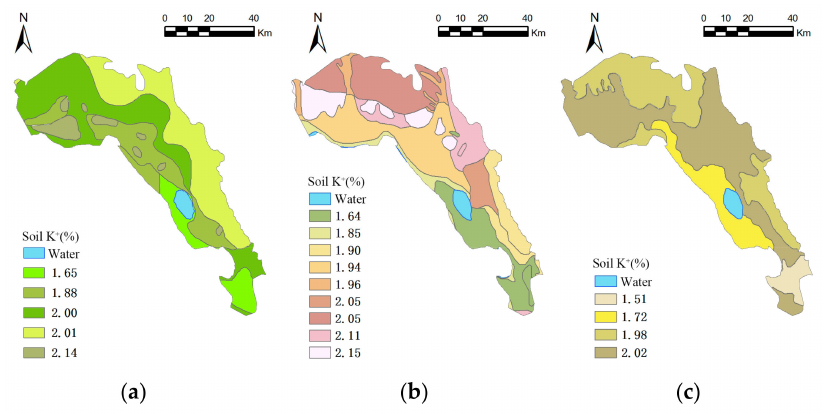
Figure 5. Mean surface m ( E mn ) of soil K + for different secondary variables: ( a ) land use; ( b ) geology; ( c ) soil type.